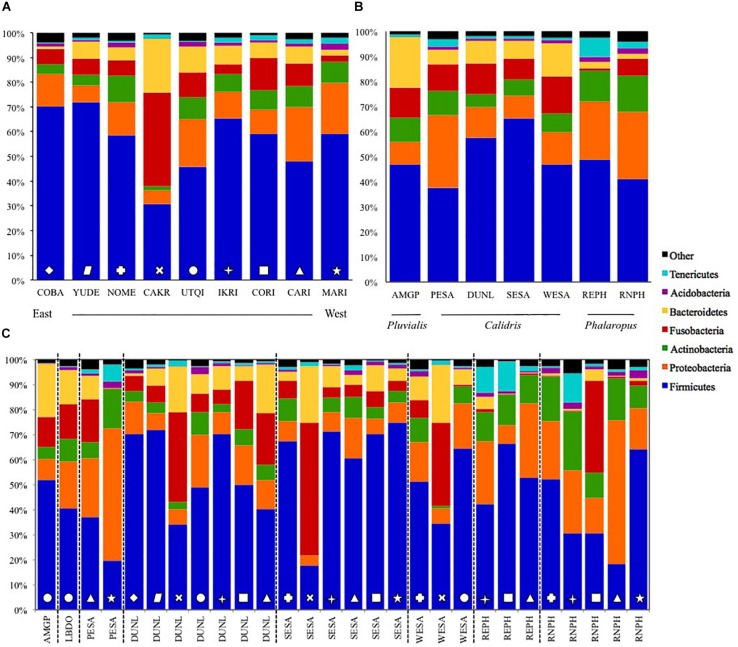
Relative abundance of fecal microbial Phyla collected from Arctic-breeding shorebirds from 2011 to 2014 averaged per site (A) and per species (B), and with site and species combined. Sites are listed from west to east, and site and species abbreviations can be found in Tables 1, 2. Symbols on bars in panel (C) represent samples from different sites, as identified in panel (A).